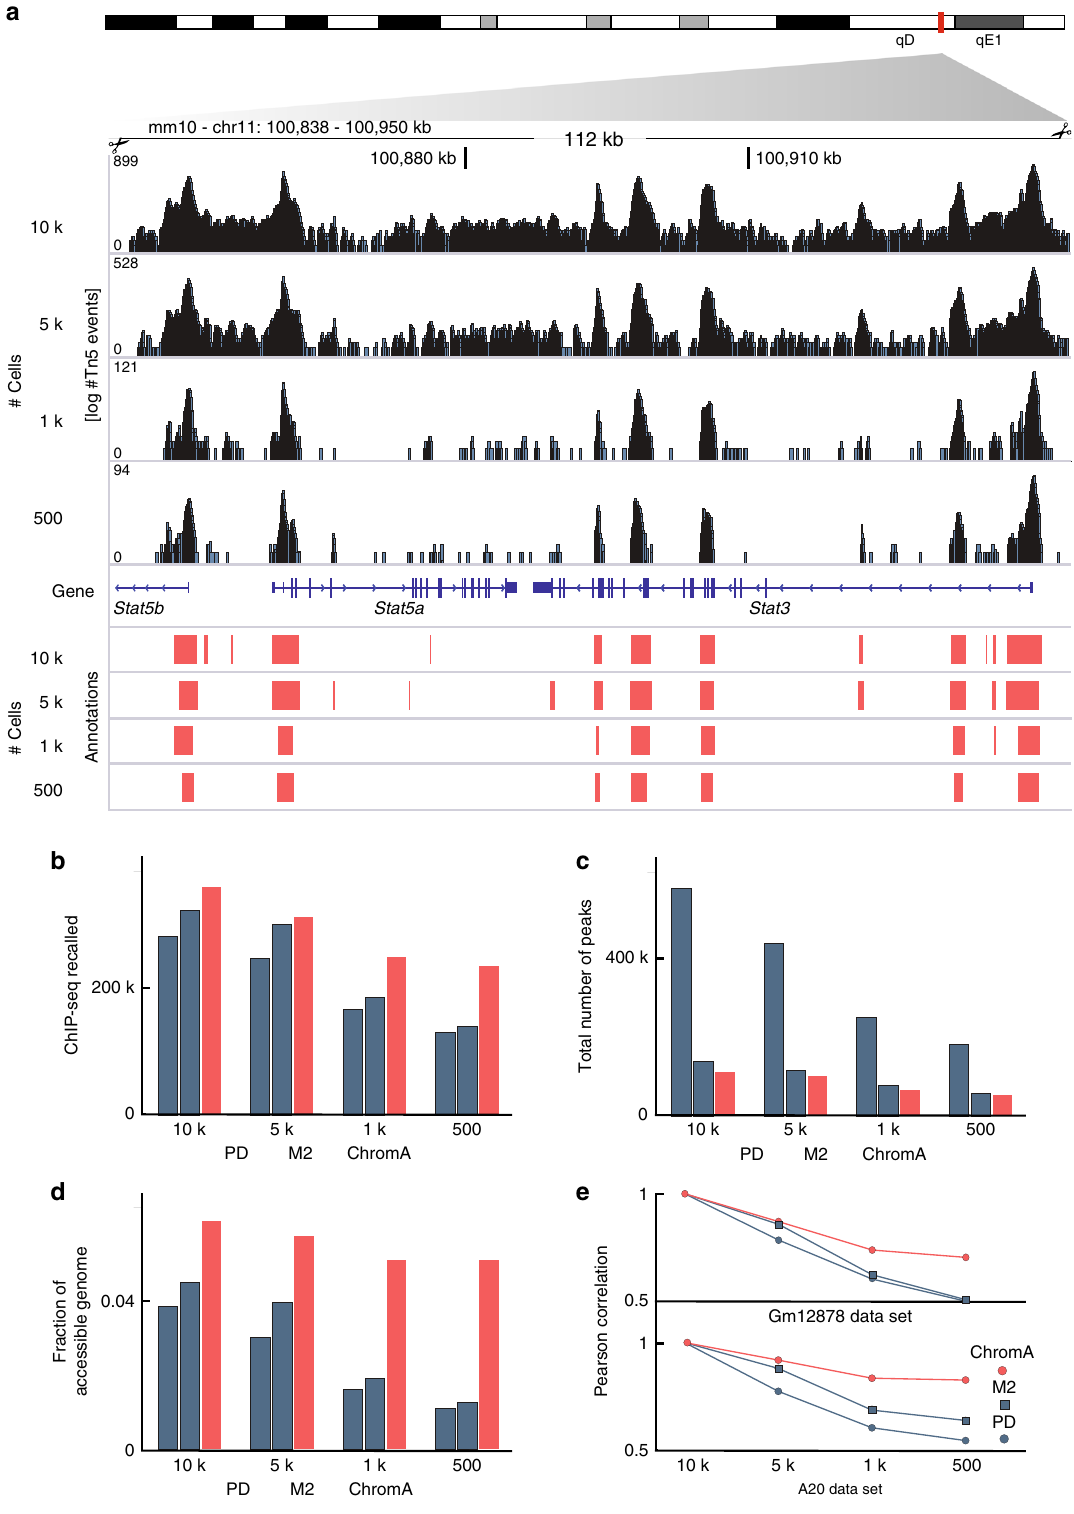
Fig. 4 ChromA annotations generalize to single-cell data sets. a Annotations of mouse A20 single-cell data sets at the Stat3 genomic locus. Cells are downsampled from 10,000 to 500 cells. ChromA annotations are consistent at different cell depths. b – e ChromA extends its effective genome-wide performance to single-cell data sets, again, recalling the highest number of ChIP-seq calls in GM12878 single-cell data sets. ChromA is particularly effective at low cell depths. b The number of ChIP-seq peaks recalled, c the total number of peaks and ( d ) fraction of the genome annotated as accessible for each downsampled data set. e Correlation between annotations at different cell depths calculated against the entire data set possessing 10,000